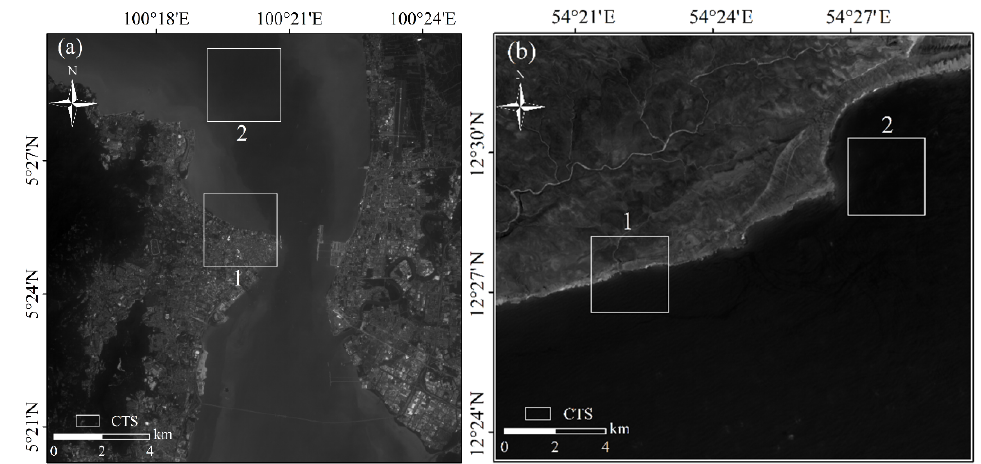
Figure 4. Distribution of the CTS in the study area. To better show the boundary between water and land, Coastal imagery is used for display. ( a ) Penang, ( b ) Socotra; 1 is a mixed area of land and water (Mixed Zone), the ratio of water to land is 1:1, and 2 is the water-only area (Water Zone). Similar to Penang, Socotra also shows a trend of decreasing and then increasing 𝑅 (cid:3045)(cid:3030) The R rc (relative rate of change), M rc (mean rate of change), and Sd (standard devia- span values with the increasing wavelength in the Mixed Zone, and the inflection point tion) are used to quantify the CTSs. The above indices can vividly represent the relative appears in the green band. With the increase in 𝑅 (cid:3041)(cid:3046) in the same band, 𝑅 (cid:3045)(cid:3030) gradually de- differences between each pixel of the two models and the degree of dispersion of the changes. As shown in Equations (16)–(18), n represents the number of water pixels in creases, but the range of variation increases gradually. The relative change rate ranges of the the red band under different 𝑅 (cid:3041)(cid:3046) values are 16.4%, 18.8%, 19.9%, and 21.8%, and those of the NIR band are more obvious. It can be seen from Figure 6 that the 𝑅 (cid:3045)(cid:3030) at the water– land mixture is larger, mainly due to not only AE but also the influence of mixed pixels.